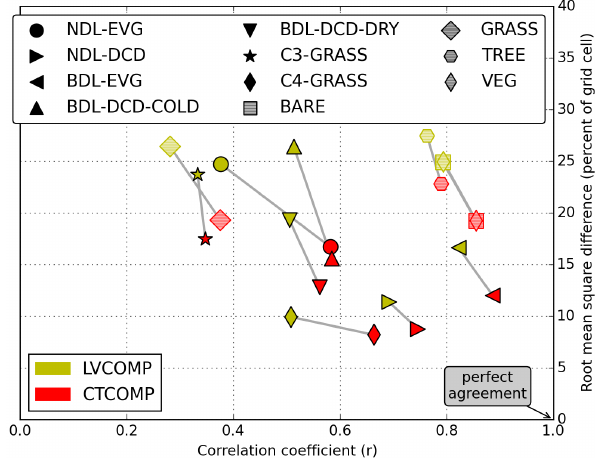
Figure 5. Scatter plot of the model simulated vegetation cover root mean square difference and correlation coefficient as compared to the observation-based estimate derived from the modified Wang et al. (2006) data set. Perfect agreement between the model and the observation-based values would yield a RMSD of zero and a cor- relation coefficient of 1. All simulations by CTCOMP show closer agreements with the W2006 data set than the corresponding LV- COMP simulations (each simulation pair between LVCOMP and CTCOMP for each PFT/aggregate is linked with a grey